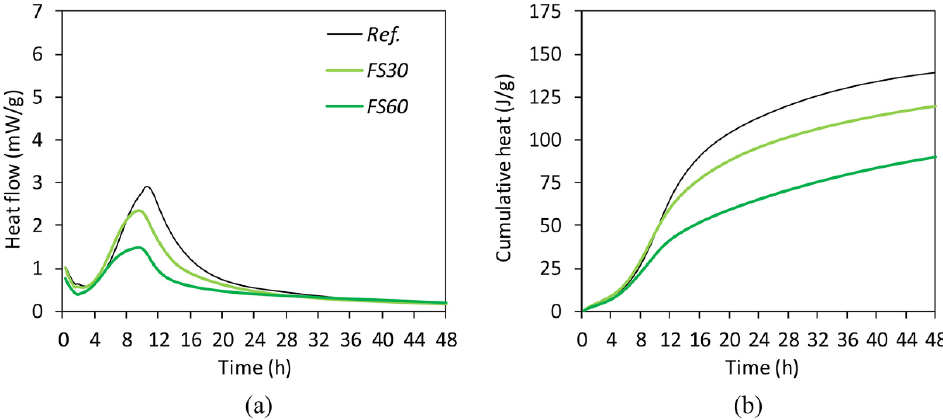
Figure 4. Isothermal calorimetry curves for the paste mixed with GGBS: ( a ) heat flow and ( b ) cumulative heat [73].